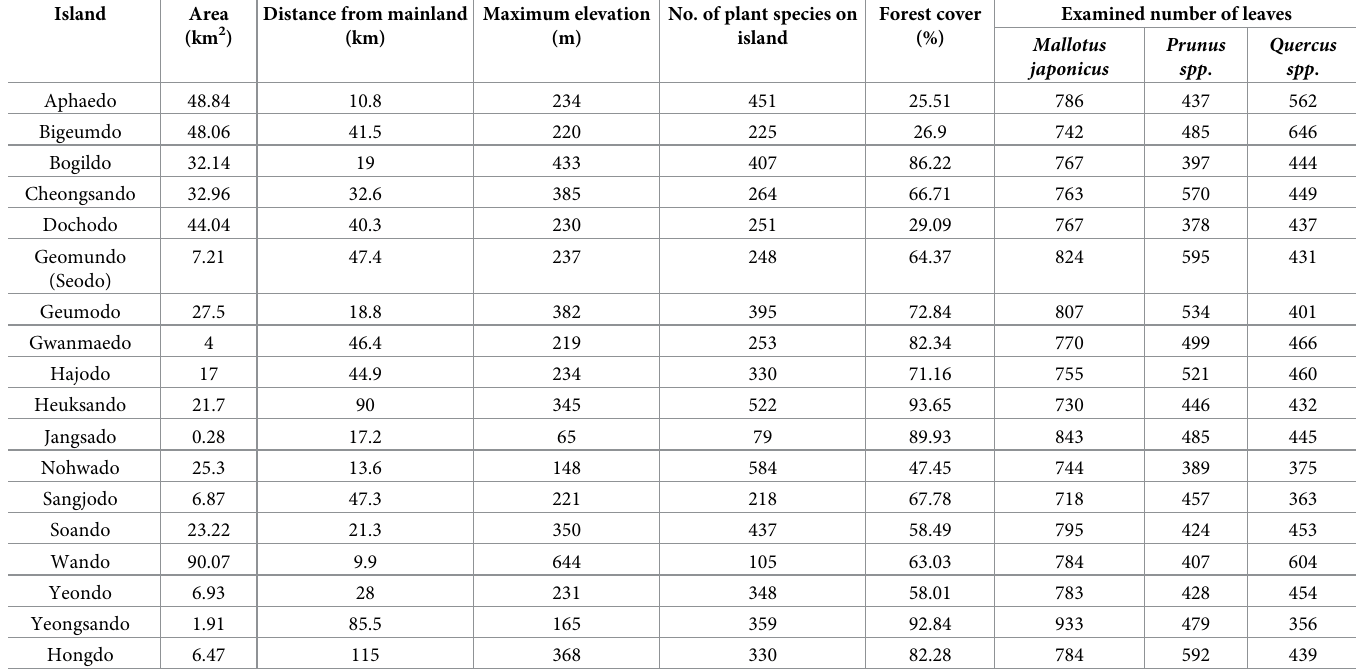
of the island. Table 1. Geographic data and the number of examined leaves of three common plant species on 18 surveyed islands in southwest Korea. Island Area Distance from mainland Maximum elevation No. of plant species on Forest cover Examined number of leaves (km 2 ) (km) (m) island (%) Mallotus Prunus Quercus japonicus spp . spp